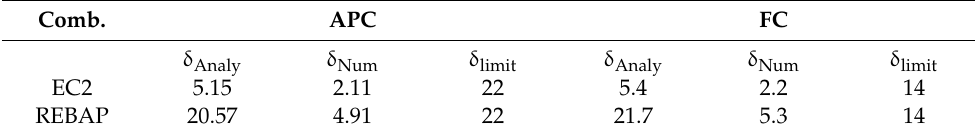
Table 14. Deformation and limit values of the 2NLM for the third case of study (values in mm).